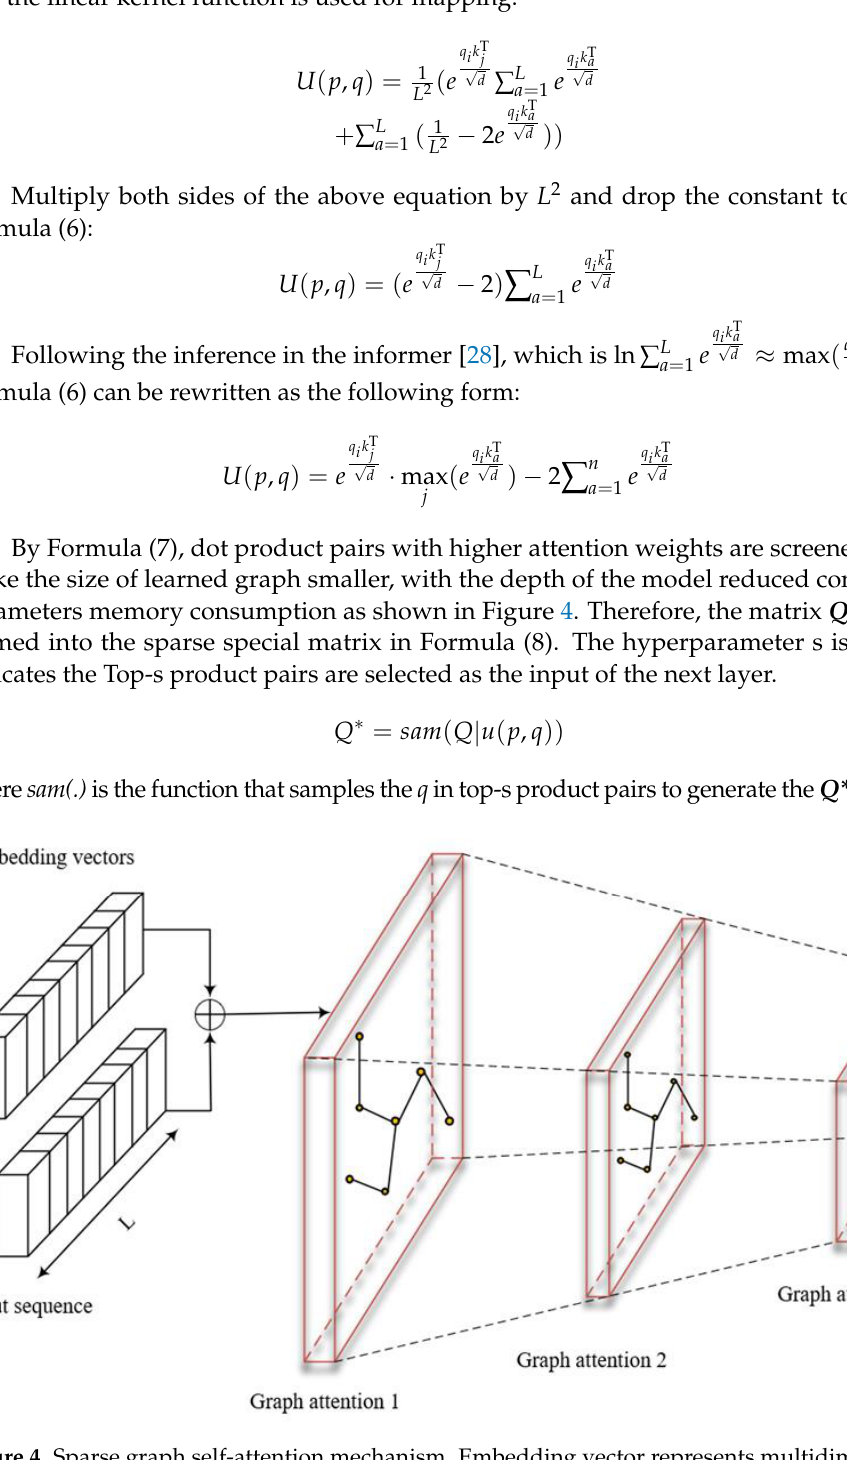
Figure 4. Sparse graph self-attention mechanism. Embedding vector represents multidimensional variable embedding.